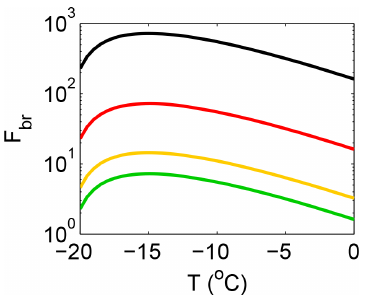
Figure 4. Number of fragments generated per collision as a func- tion of temperature estimated with the original Takahashi formula (black) or scaled with a factor of 10 (red), 50 (yellow) or 100 (green) to represent ice particles of the millimeter, 500µm and 100µm size, respectively, that undergo